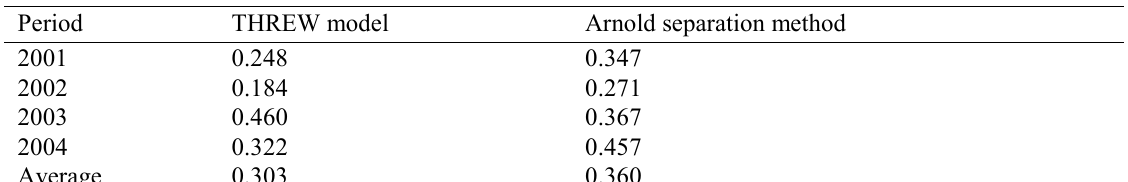
Table 1 The comparison of annual baseflow index.